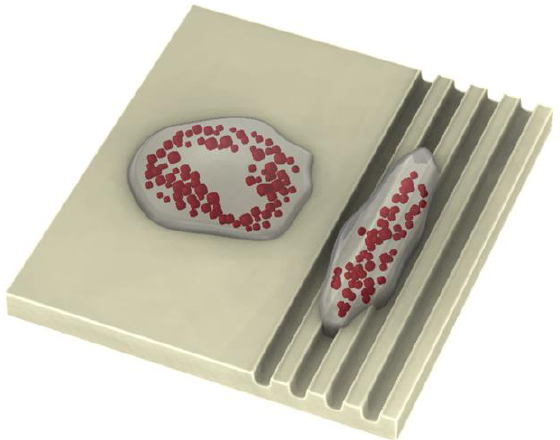
Figure 13. Adipocytes on a flat substrate and on grooves according to the experimental